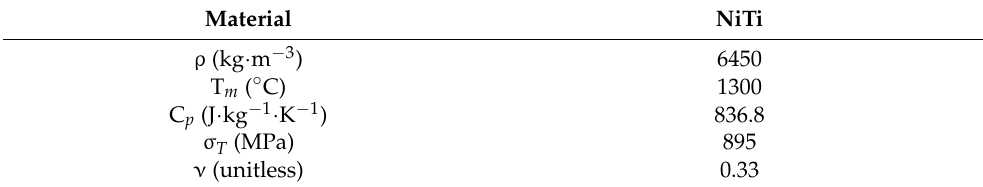
Table 2. Constant material properties of NiTi used for simulation.